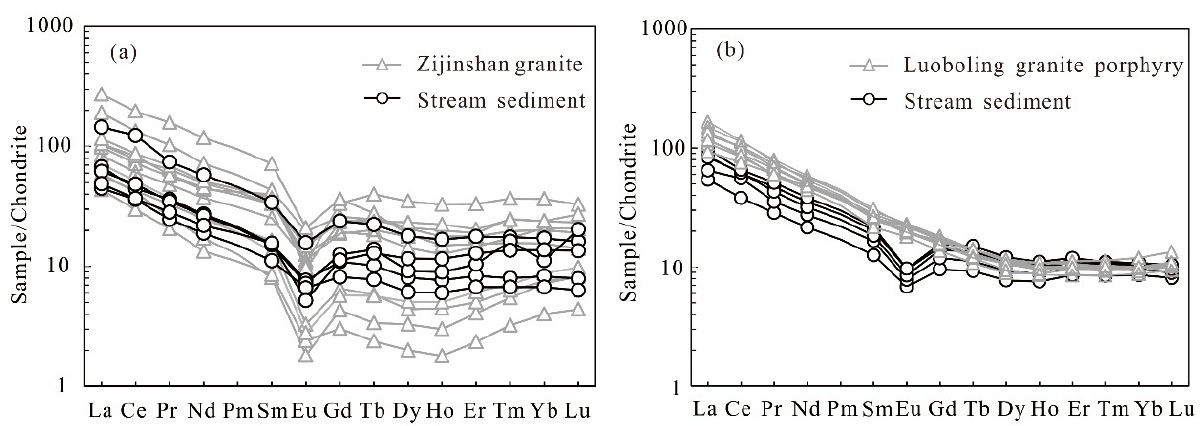
Figure 3. Chondrite-normalized REE patterns of stream sediments in the Zijinshan Copper-Gold Orefield. Chondrite normalized data are from [43]. ( a ) Stream sediments around Zijinshan copper- gold deposit; ( b ) Stream sediments around the Luoboling copper-molybdenum deposit. Data of ore-bearing magmatic rocks in the orefield are from